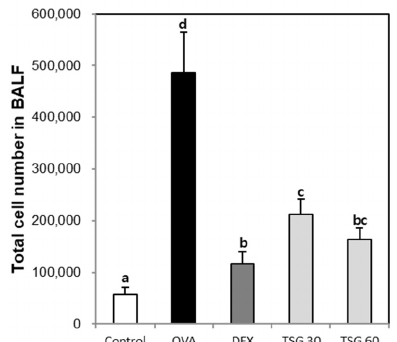
Figure 2. The effect of TSG on total cell number in the bronchoalveolar lavage fluid (BALF). Mice were sacrificed 24 h after the last challenge, and the lungs were lavaged four times with 0.5mL ice-cold saline via a tracheal cannula. The BALF was then centrifuged and the pellets were re-suspended with 1000 μL and used for cell counting. Group data are expressed as means ± SD for five mice per group. a, b, c, and d: The means not sharing a common letter are significantly different between groups at p < 0.05 as measured by one-way ANOVA with Duncan’s multiple-range test. Int. J. Mol. Sci. 2018 , 19 , x